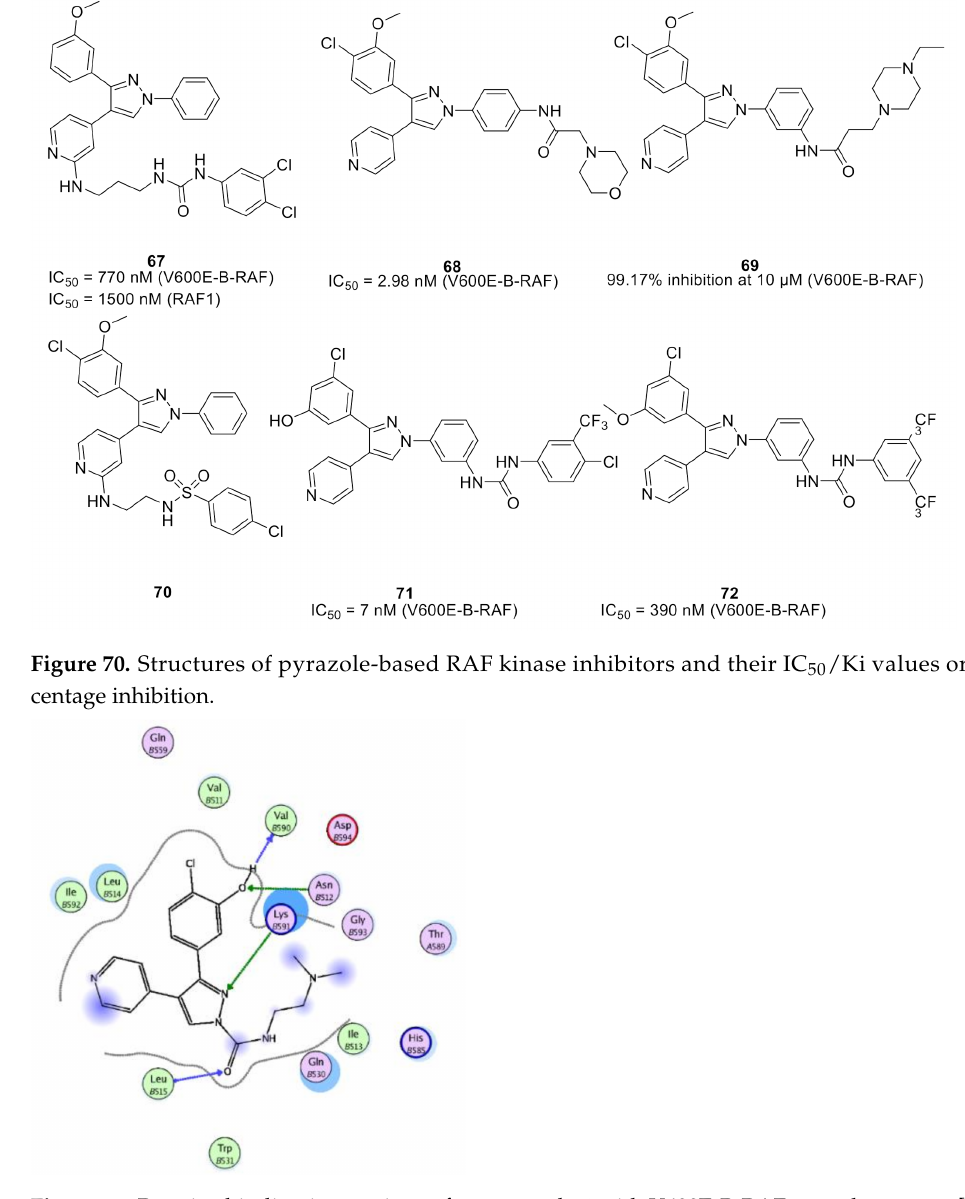
Figure 71. Putative binding interactions of compound 64 with V600E-B-RAF crystal structure